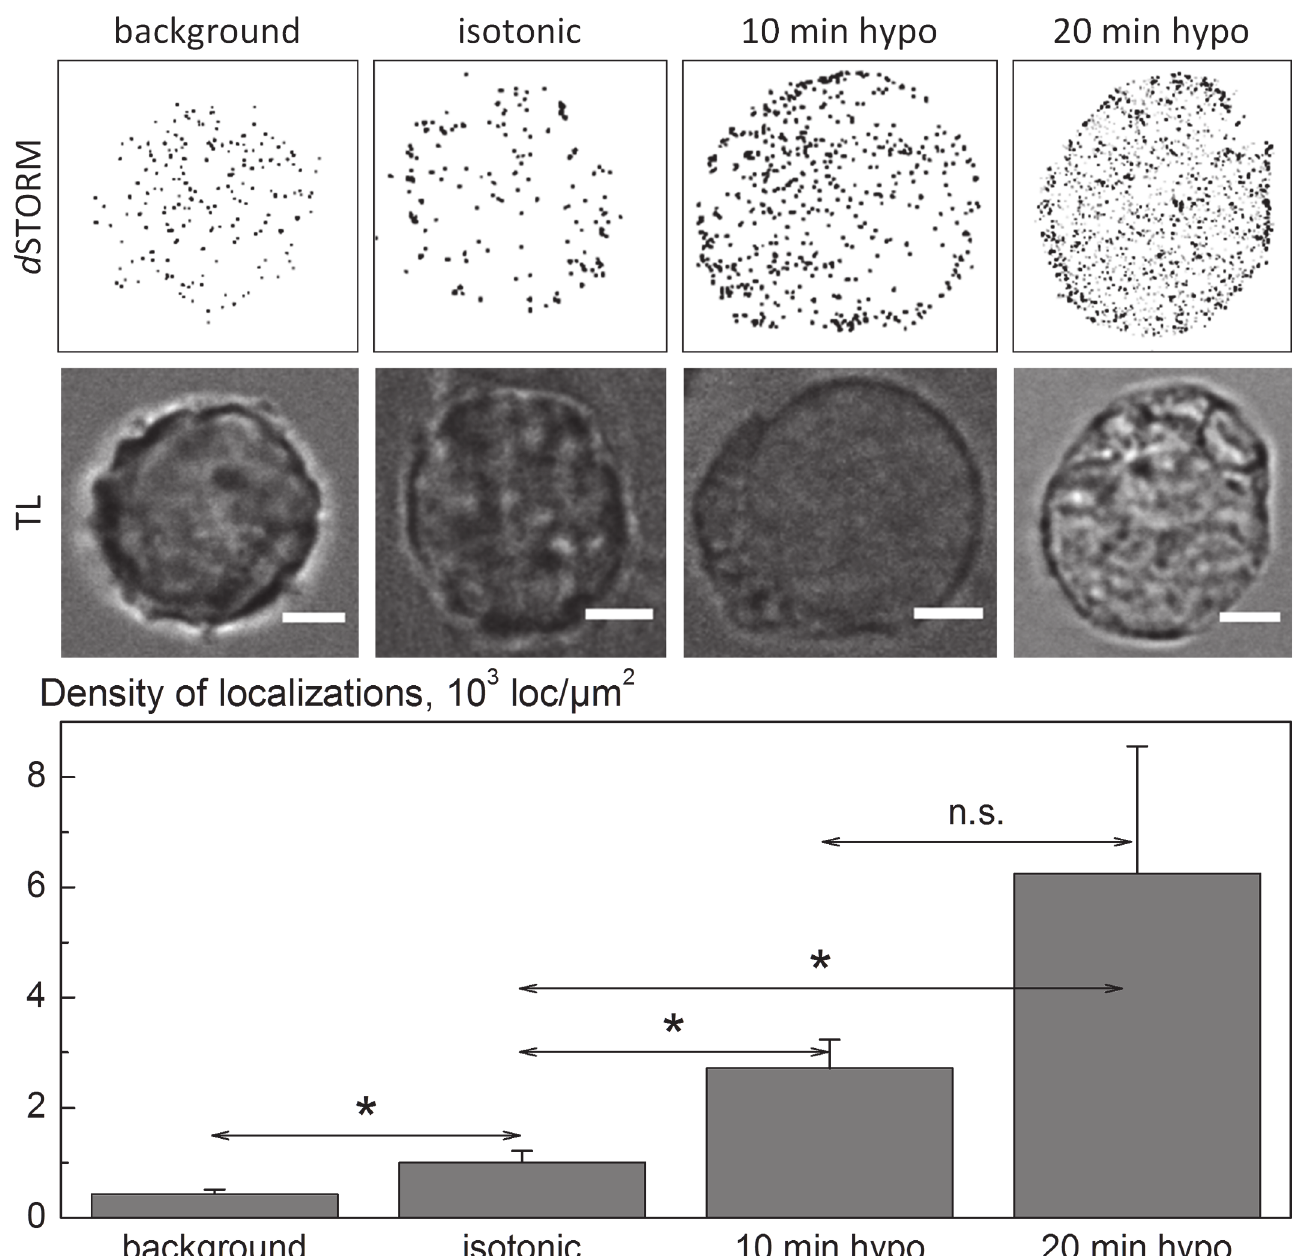
Fig 5. d STORM imaging of immunolabeled SLC5A3 protein in the plasma membrane of HEK293 cells under isotonic and hypotonic conditions. Images of the same cells in transmitted light (TL) are also shown. From the d STORM images (reconstructed from 15,000 single frames), the surface membrane density of SLC5A3 localizations [loc/ μ m 2 ] were identified in individual cells. The bar graph shows the impact of hypotonic stress on the surface membrane density of SLC5A3 protein localizations. The data are means ( ± SD) from 8 – 16 individual cells for each osmotic condition and hypotonic stress duration. The differences in the mean values between the isotonic control and the two hypotonic samples were statistically significant (as denoted by * ; P < 0.05), according to the Mann-Whitney test conducted using the Software Origin 9 (Microcal, Northampton, MA). The difference between the two hypotonic samples (10 vs 20 min) was not significant